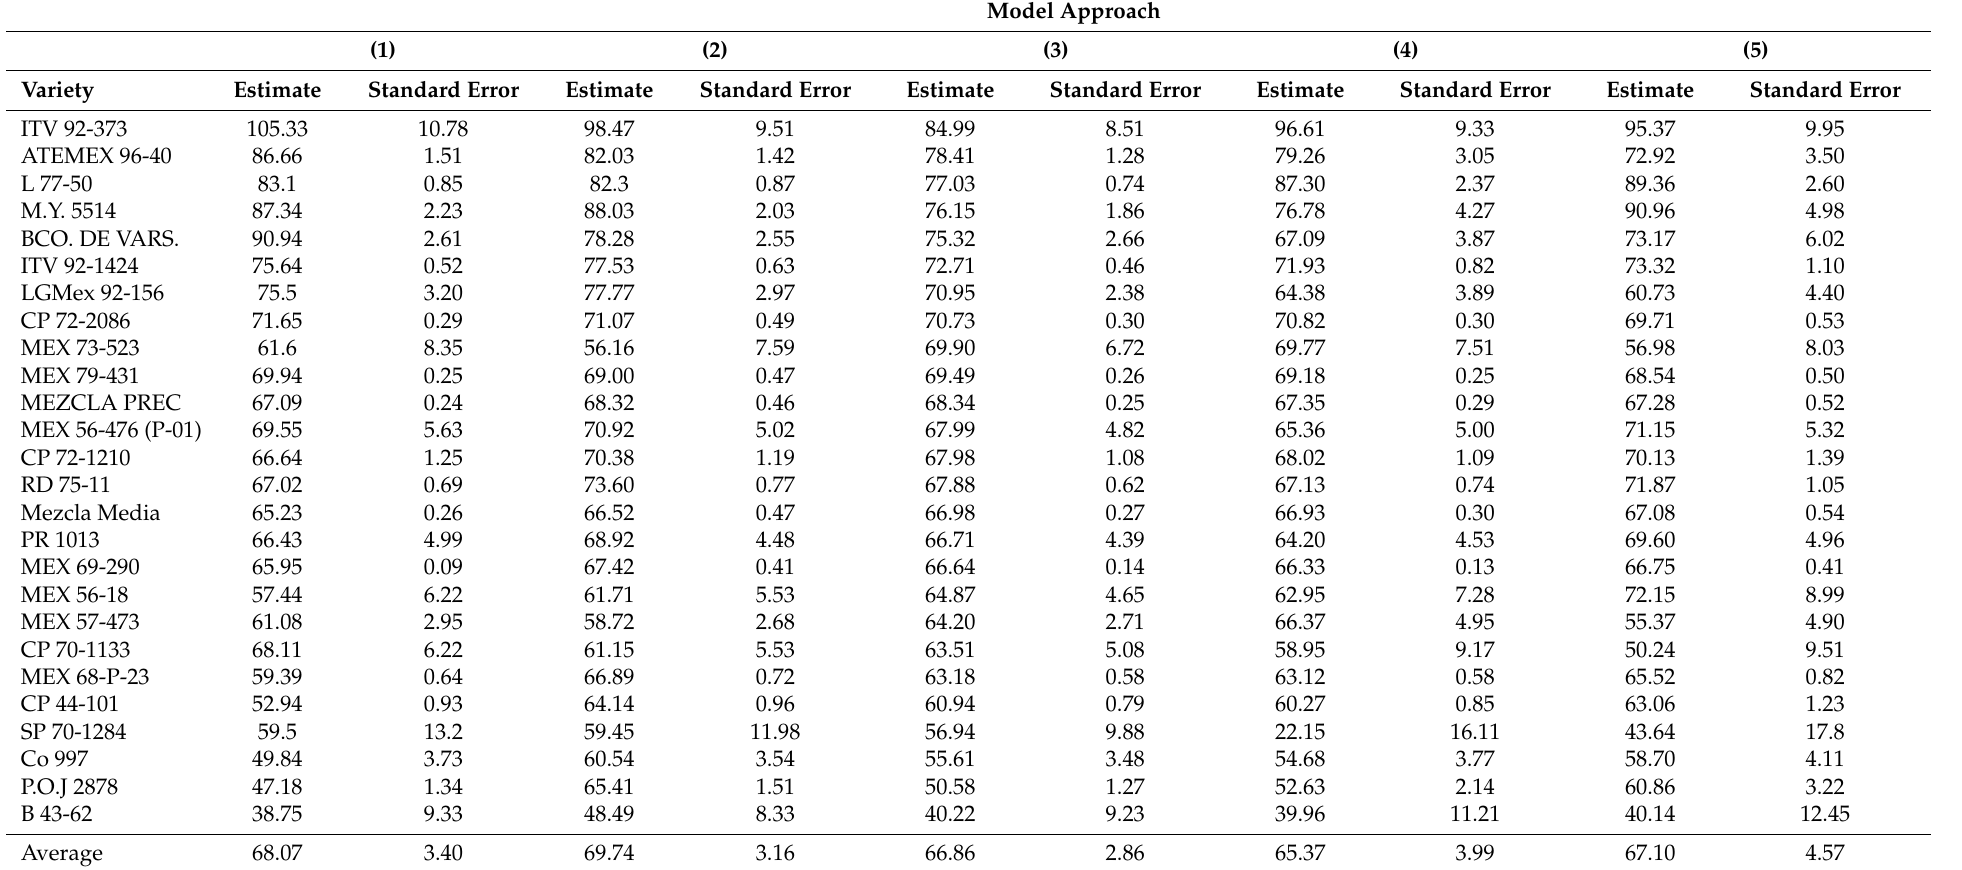
Table 5. Mean sugarcane yield (Mg/ha) and standard error of mean for each model and sugarcane